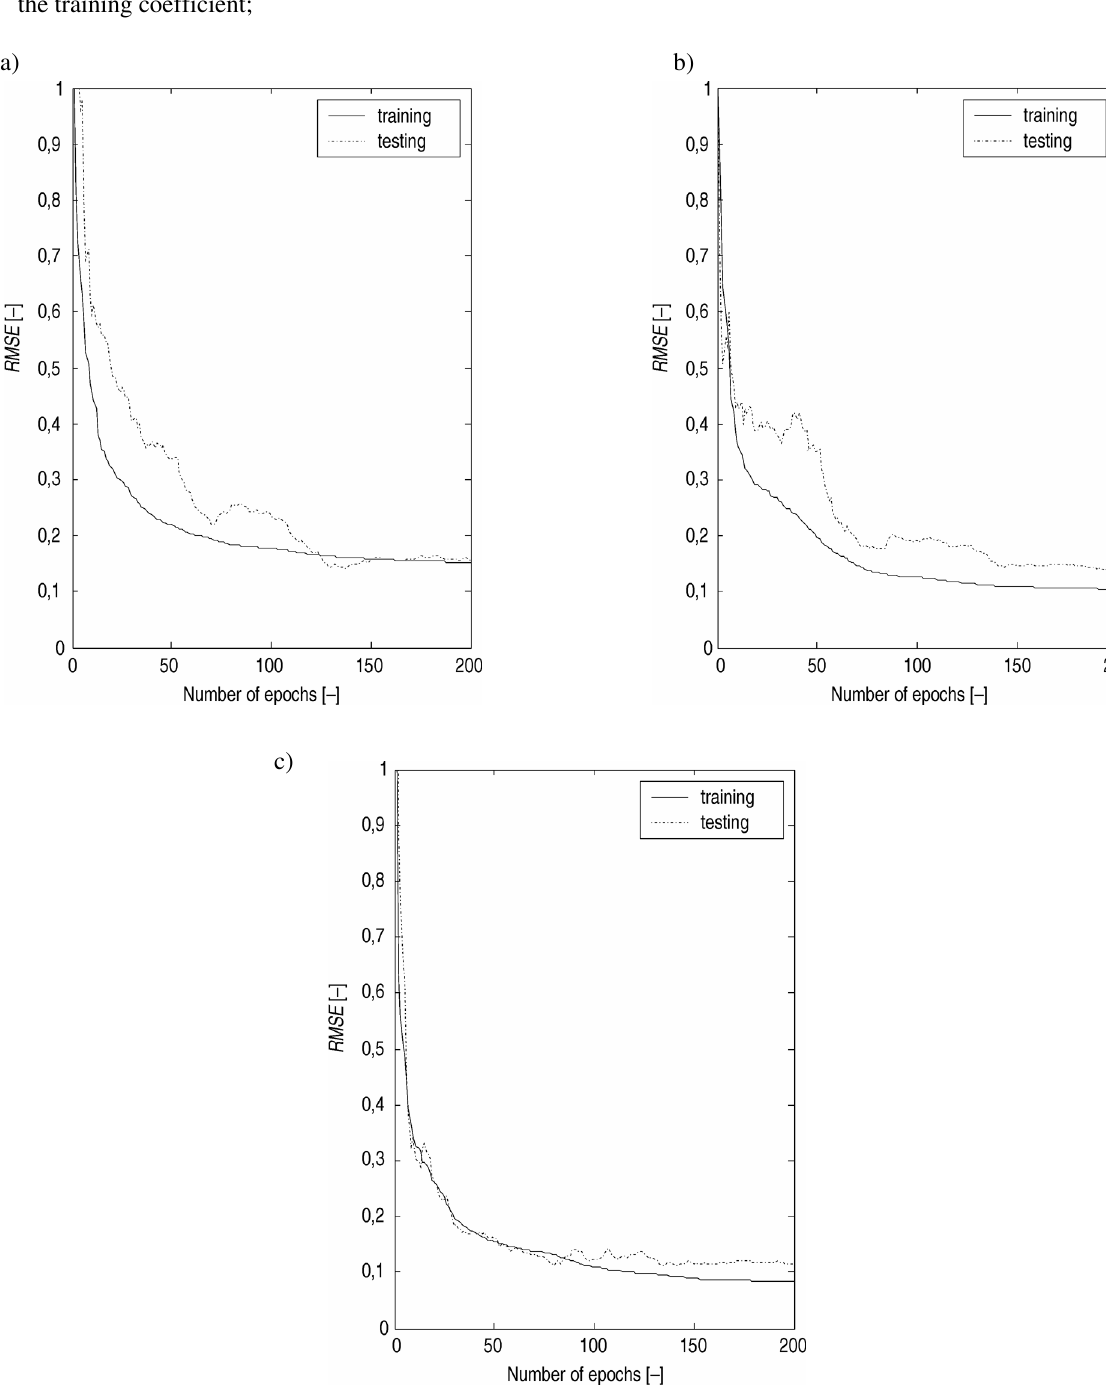
Fig 7 . Neural network training and testing RMSE versus number of epochs for productivity W (N),S and hauling distance of a) 2 km, b) 5 km, c) 7